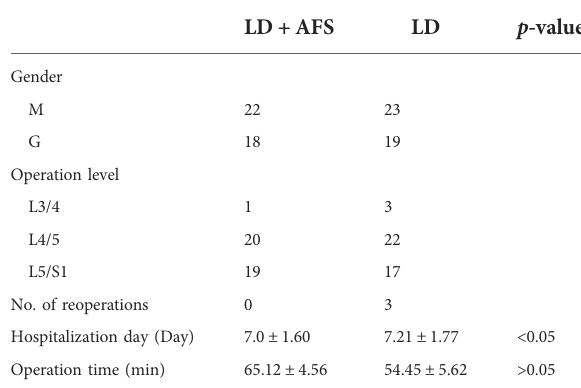
TABLE 1 Baseline data.